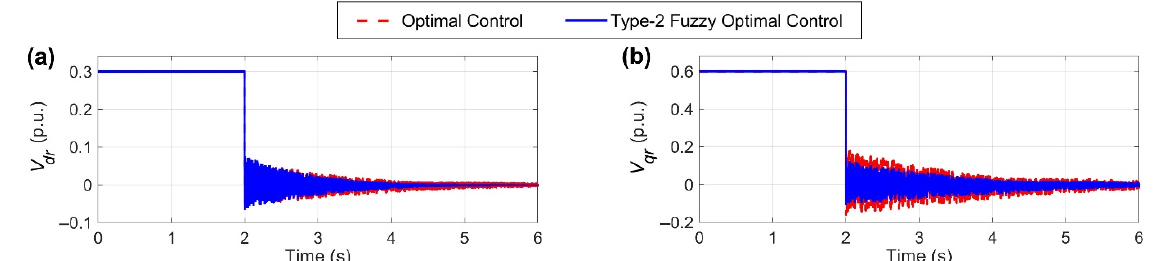
Figure 5. The shapes of ( a ) and ( b ) are related to the rotor voltage signals along with the d and q vectors as control signals, respectively. Before the moment 𝑡 = 2 s , the system is in its stable state, and at 𝑡 = 2 s , disturbance enters the system.